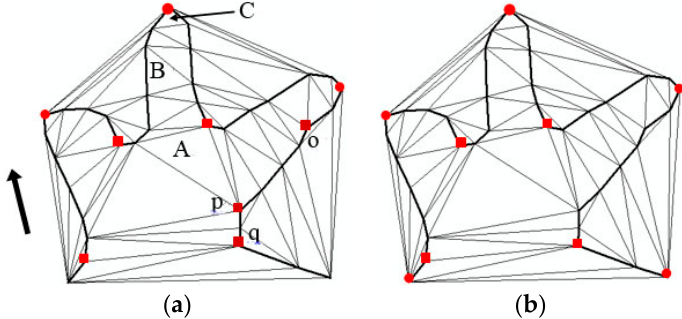
Figure 1. The extraction of characteristic points. ( a ) Raw characteristic points with pseudo-characteristic points. ( b ) Final characteristic points after excluding the pseudo-characteristic points and supplementing with the endpoints.